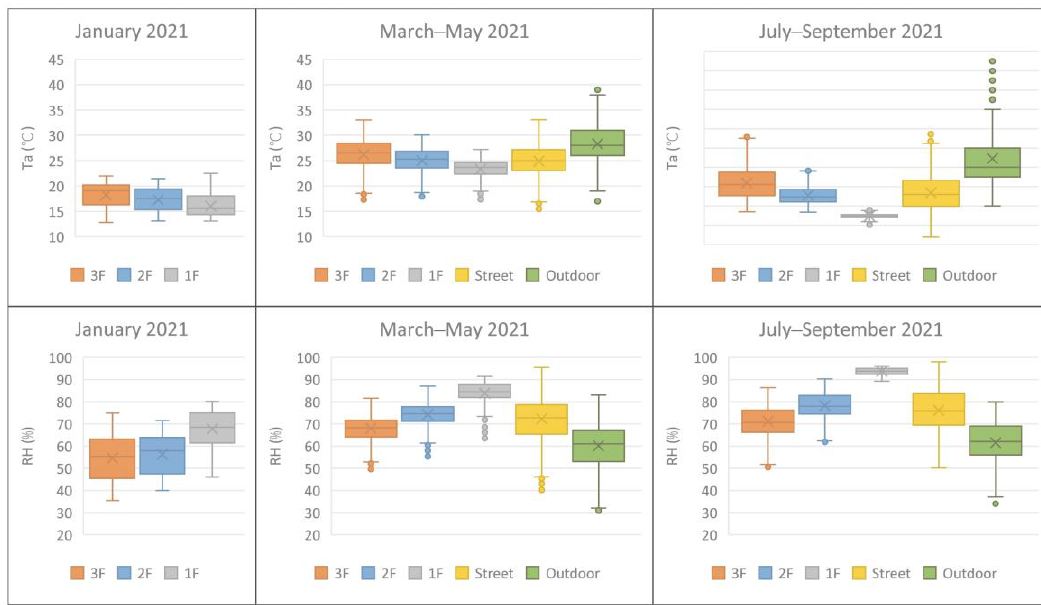
Figure 15. Average Ta and RH measurement data (January – September 2021), drawn by the students.